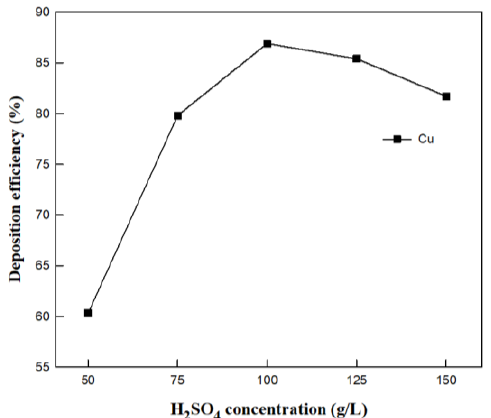
Figure 7. Effect of H 2 SO 4 concentration on Cu deposition efficiency. Electrodeposition conditions: H 2 SO 4 50–150 g/L, current density 15 mA/cm 2 , 4 h, 45 °C.